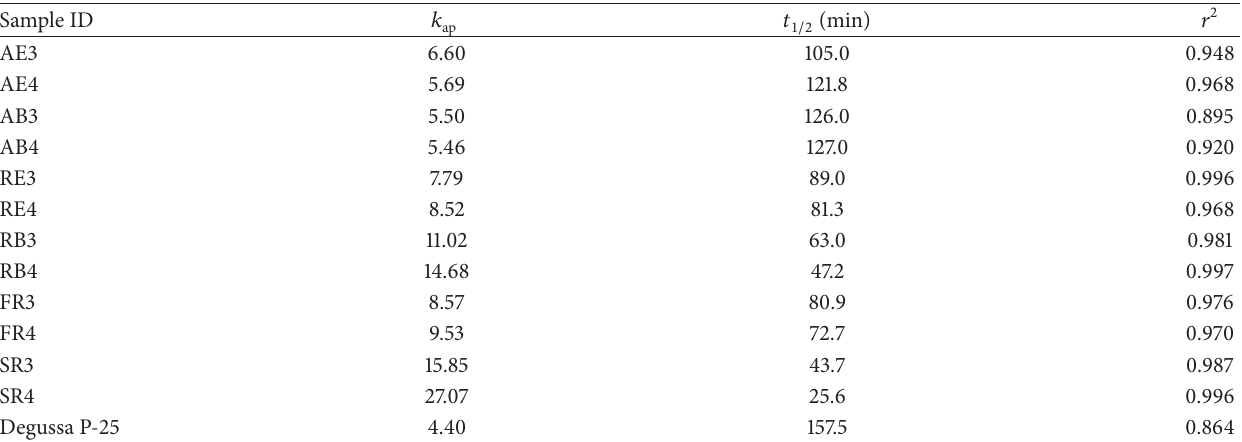
Figure 3: N 2 adsorption-desorption isotherms and pore size distribution of the mesoporous anatase phases dried (a) at room temperature (b) in rotary evaporator (c) with different rate in rotary evaporator and calcined at 350 ∘ C (d) with different rate in rotary evaporator calcined at 400 ∘ C. Table 4: Apparent constant, half-life, and linearization coefficient for the Langmuir-Hinshelwood model for 4CP